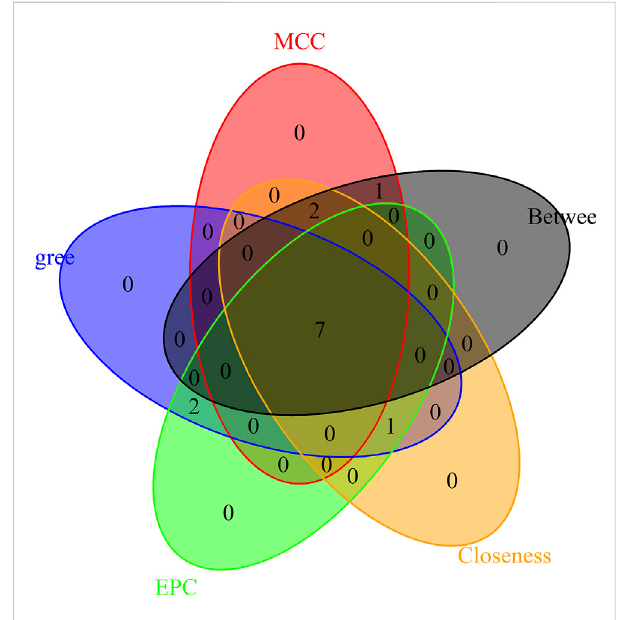
FIGURE 6 Venn diagram of fi ve methods to screen the top ten hub genes.